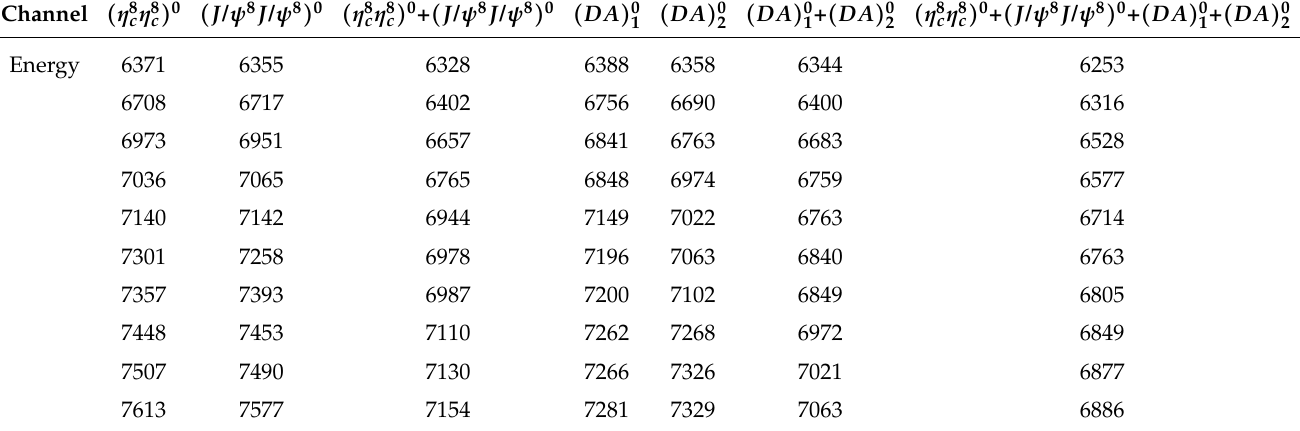
Table 5. The energy spectra for the cc ¯ c ¯ c states with J PC = 0 ++ in the single hidden-color channel and hidden-color channels coupling (unit: MeV).